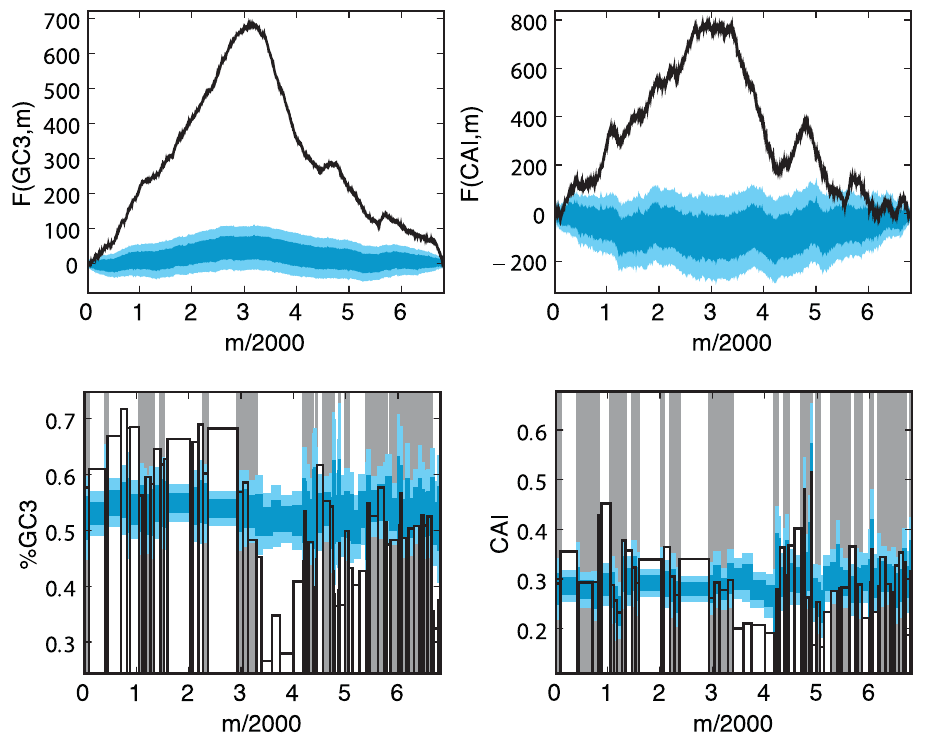
Figure 3. Observed and randomized landscapes for lambda phage. The figure shows the observed GC3 (left) and CAI (right) landscapes, plotted in black, along with the mean 6 1, and 6 2 standard deviations of randomized trials, shown in aqua (bold line, dark and light regions, respectively). The aqua randomization test shown here draws random synonymous codons that preserve the exact amino acid sequence, according to probabilities that preserve the global codon usage distribution of the lambda genome. For the most part, the observed landscapes lie significantly outside the distribution of randomized landscapes–implying that the amino acid content of genes is not responsible for the observed pattern of the CAI landscape. In the lower panel, however, genes whose GC3 (left) or CAI (right) values fall between the 0.025 and 0.975 quantile of the random trials are shadowed in grey; the GC3/CAI values of such genes are not significantly different from random, given their amino acid sequence.